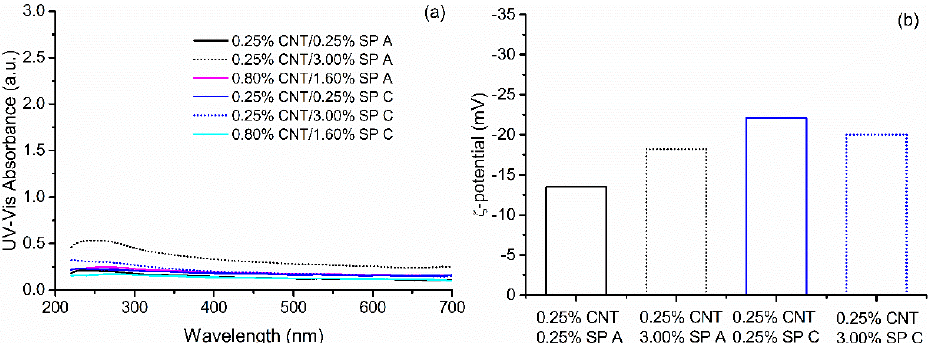
Figure 7. ( a ) UV–Vis absorbance spectra and ( b ) ζ -potential values obtained from different CNT–SP variations using SPs A and C. variations using SPs A and